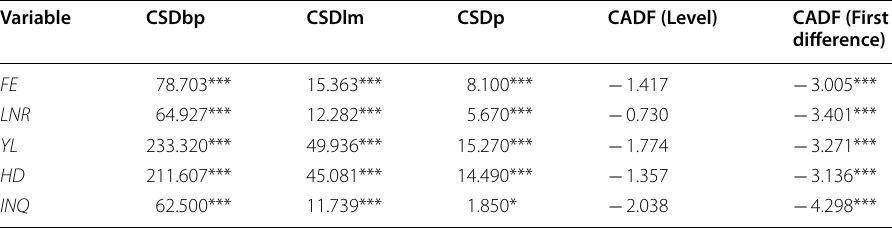
Table 7 CSD and unit rot tests